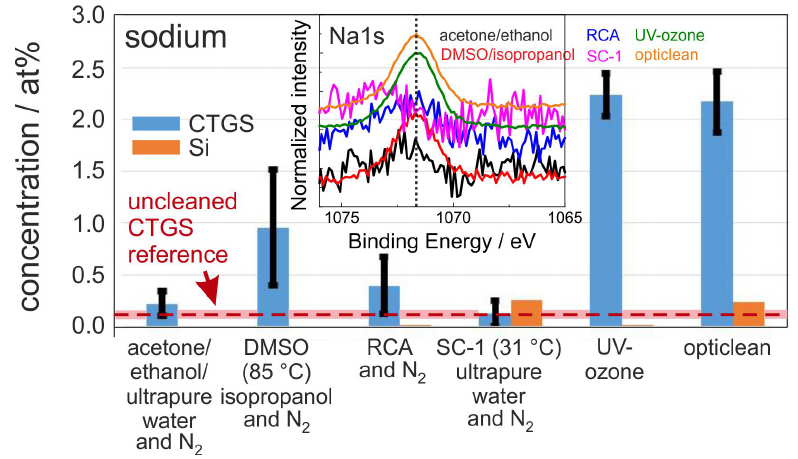
Figure 2. Mean value of sodium concentration after the respective cleaning procedure measured with XPS (Al-source with neutralizer) on the CTGS surface and on Si reference. The red dashed line represents the mean sodium values of the unclean CTGS reference samples of about 0.14 at %. The light red stripe indicates the corresponding standard deviation of 0.04 at %. The inset shows the normalized Na1s spectra of one set of samples. The black dotted line marks the theoretical position of the Na1s